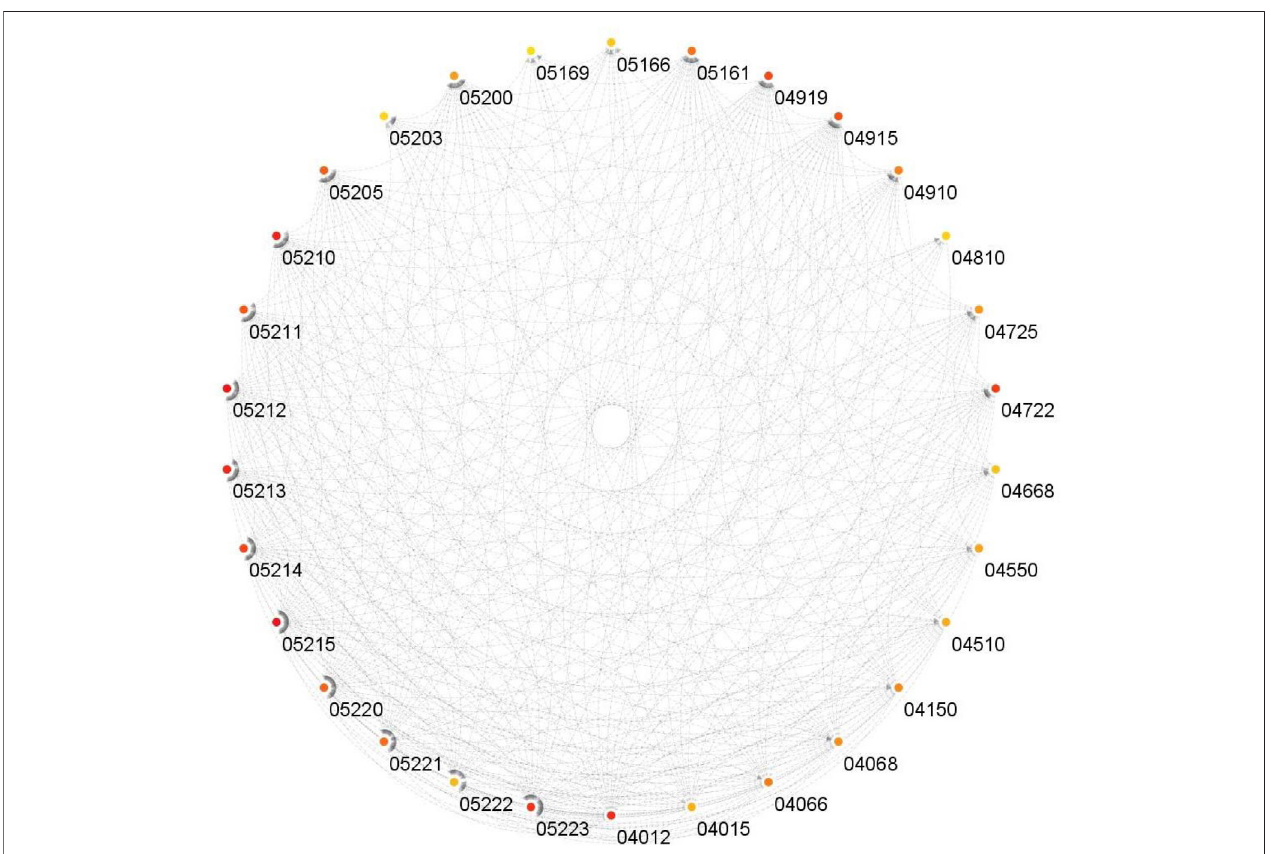
FIGURE 8 | Interactions of the commonly overrepresented pathways in all datasets.